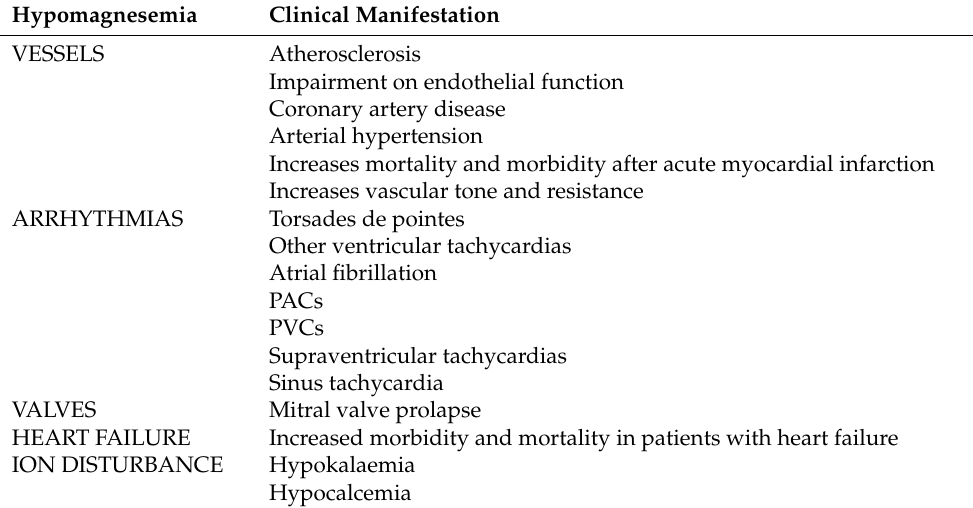
Table 1. Clinical manifestations of hypomagnesemia potentially influencing the cardiovascular system [25].